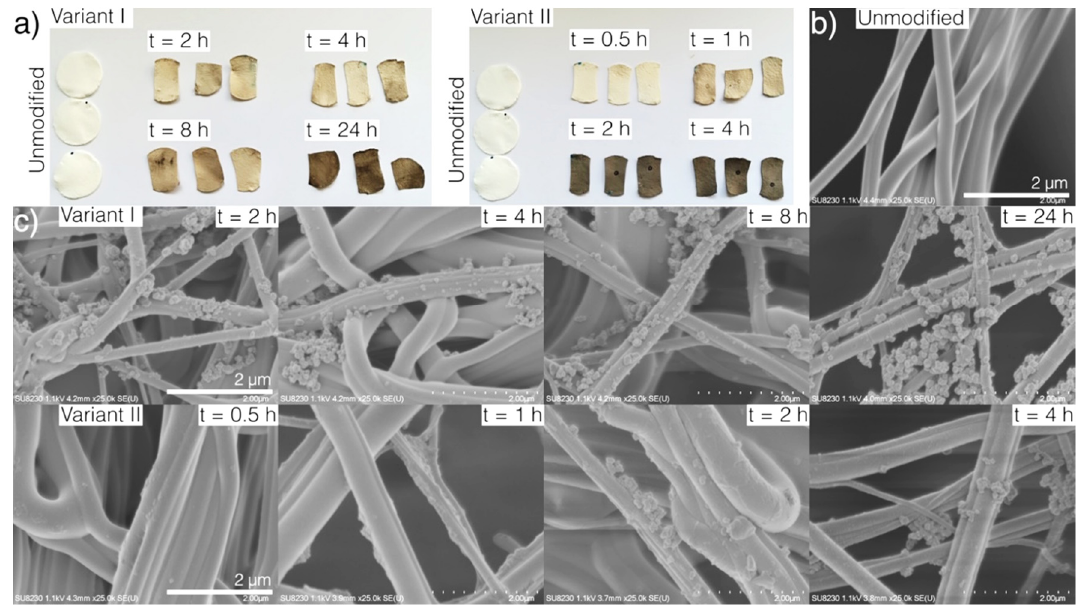
Figure 1. ( a ) pictures of unmodified and modified polyurethane (PU) nanofibrous materials, scanning electron microscopy (SEM) images of ( b ) unmodified, and ( c ) modified PU nanofibrous materials.